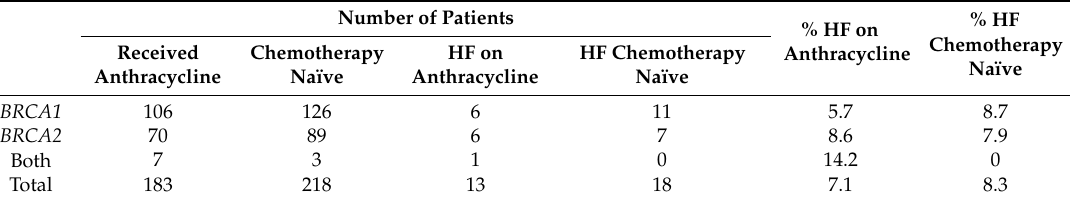
Abbreviations: HF, heart failure.